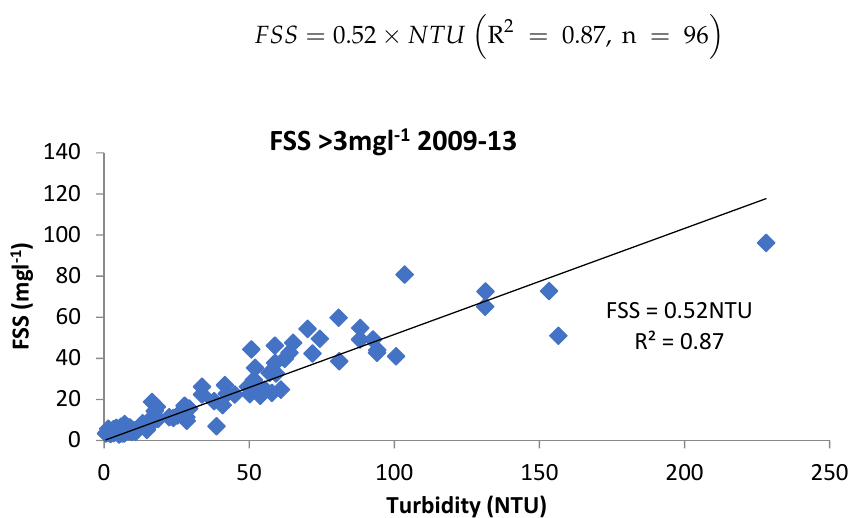
Figure 5. The variation of FSS with NTU for GCUS for water years 20092013 (n = 96). The relationship between FSS and NTU at GCUS derived by Moliere et al. [41] using the data available at that time (discontinuous data between 2004 to 2007) was: Because, Equation (3) had a higher R 2 value than Equation (4), the earlier will be used for analysis of GCUS events. For GCDS, the NTU–FSS relationship determined for data from 2008–2010 is shown in Figure 6.